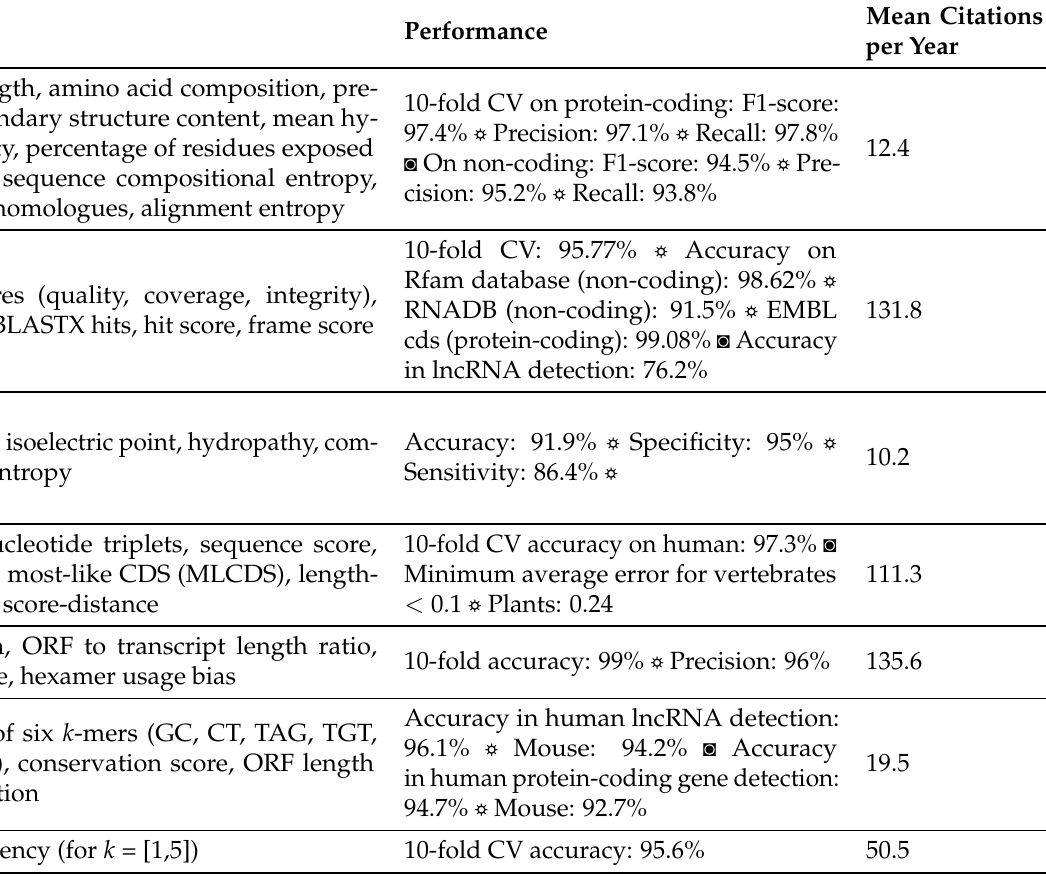
Table 1. LncRNA detection tools: Some of the essential characteristics of the reviewed lncRNA detection tools are summarized. Latter were ordered by year of release. Furthermore, the average number of citations accumulated per year is given as an approximate impact metric. To minimize redundancy, only tools that were on average cited more than 10 times per year were included in this review, unless they contributed an explicitly unique approach in their feature design not encountered elsewhere, i.e., BASiNet and PLIT